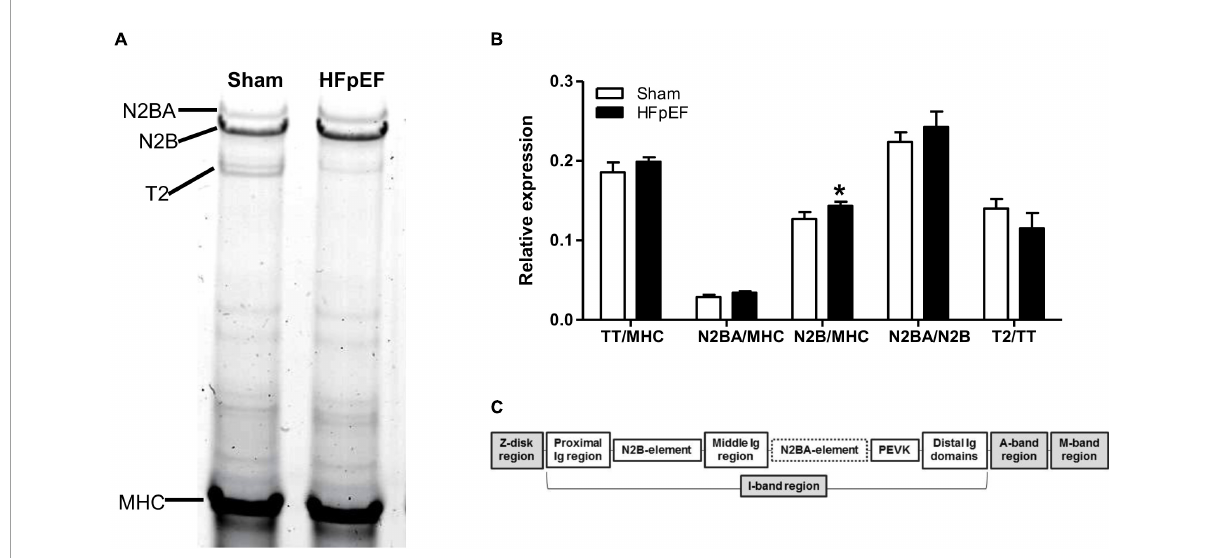
FIGURE5 Titin isoform expression. (A) Representative image of 1% agarose gel for titin analysis. (B) Quantitative analysis of total titin (TT) and titin isoforms N2BA and N2B relative to total myosin heavy chain (MHC), the ratio of N2BA to N2B, and titin degradation product (T2) relative to TT, in the left ventricles from Sham ( N = 7) and HFpEF mice ( N = 11). Data are presented as mean ± SEM. Unpaired T -test was performed, * P < 0.05 vs. Sham mice. (C) Overview of the titin molecule structure.